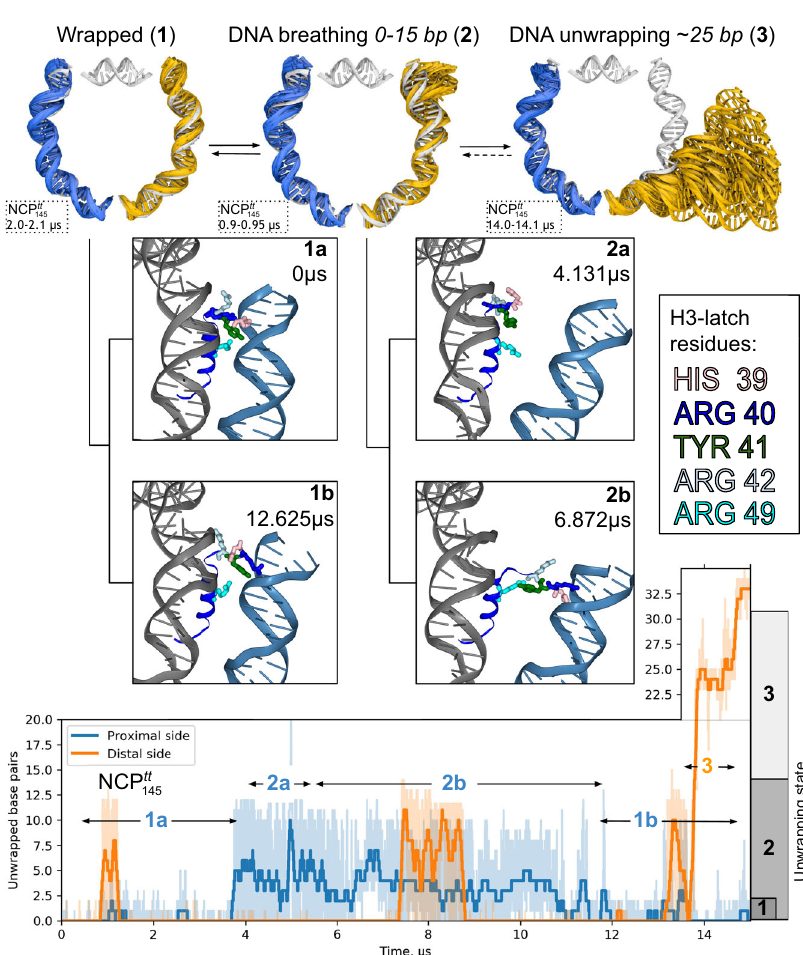
Fig. 3 Mechanisms of DNA unwrapping in nucleosomes with truncated histone tails based on NCP tt 145 simulation. Top panel: different DNA unwrapping states. Middle panel: substates within each state showing different conformations of the H3-latch residues interacting with the nucleosomal DNA end and the neighboring DNA gyre. Bottom panel: pro fi le of the extent of DNA unwrapping during MD simulations. Thin semitransparent lines are used to plot instantaneous unwrapping values; thick lines depict smoothed signal with Savitzky-Golay fi lter using 100 ns window and fi rst-degree